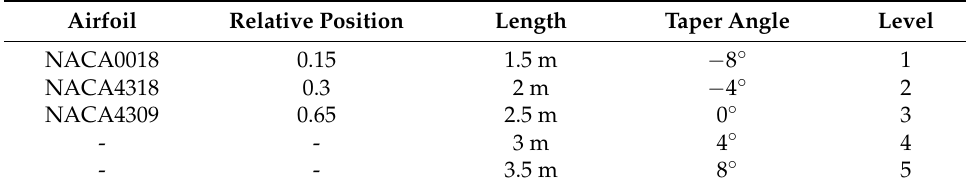
Table 8. Orthogonal parameters field of the